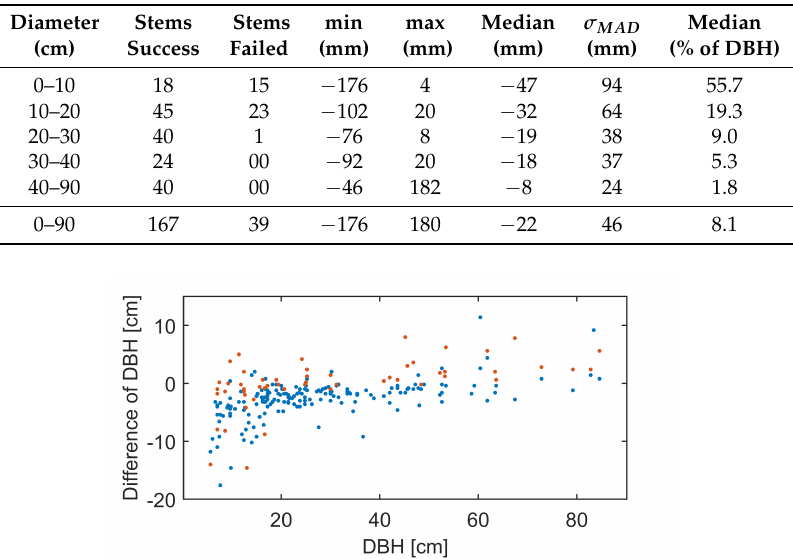
Figure 6. DBH differences; in situ measurements minus cylinder fitting estimated DBH; blue: ULS modeled; red: TLS modeled.